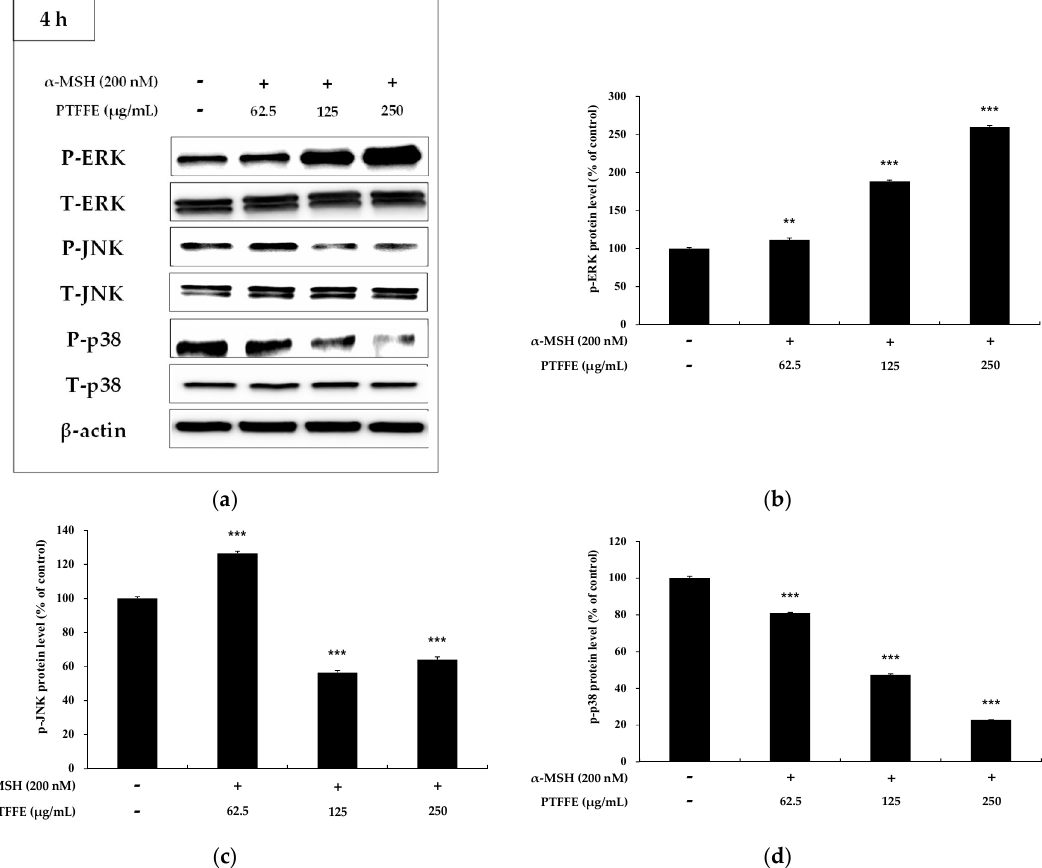
Figure 7. Effects of PTFFE on phosphorylation of ERK, p38 and JNK. B16F10 cells were treated with PTFFE at the indicated concentrations for 4 h. ( a ) Western blotting results and protein levels of ( b ) p-ERK, ( c ) p-JNK and ( d ) p-p38. Data are expressed as percentages of the untreated cells. The data are presented as the mean ± SD of at least three independent experiments. ** p < 0.01, *** p < 0.001. P: phosphorylated, T: total.